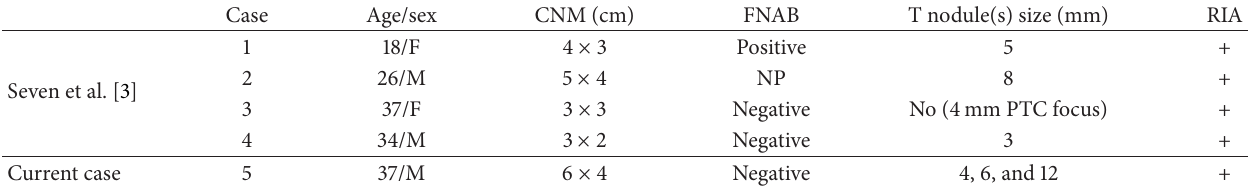
Table 1: The clinical features and presented cystic neck mass sizes of the cases are shown.